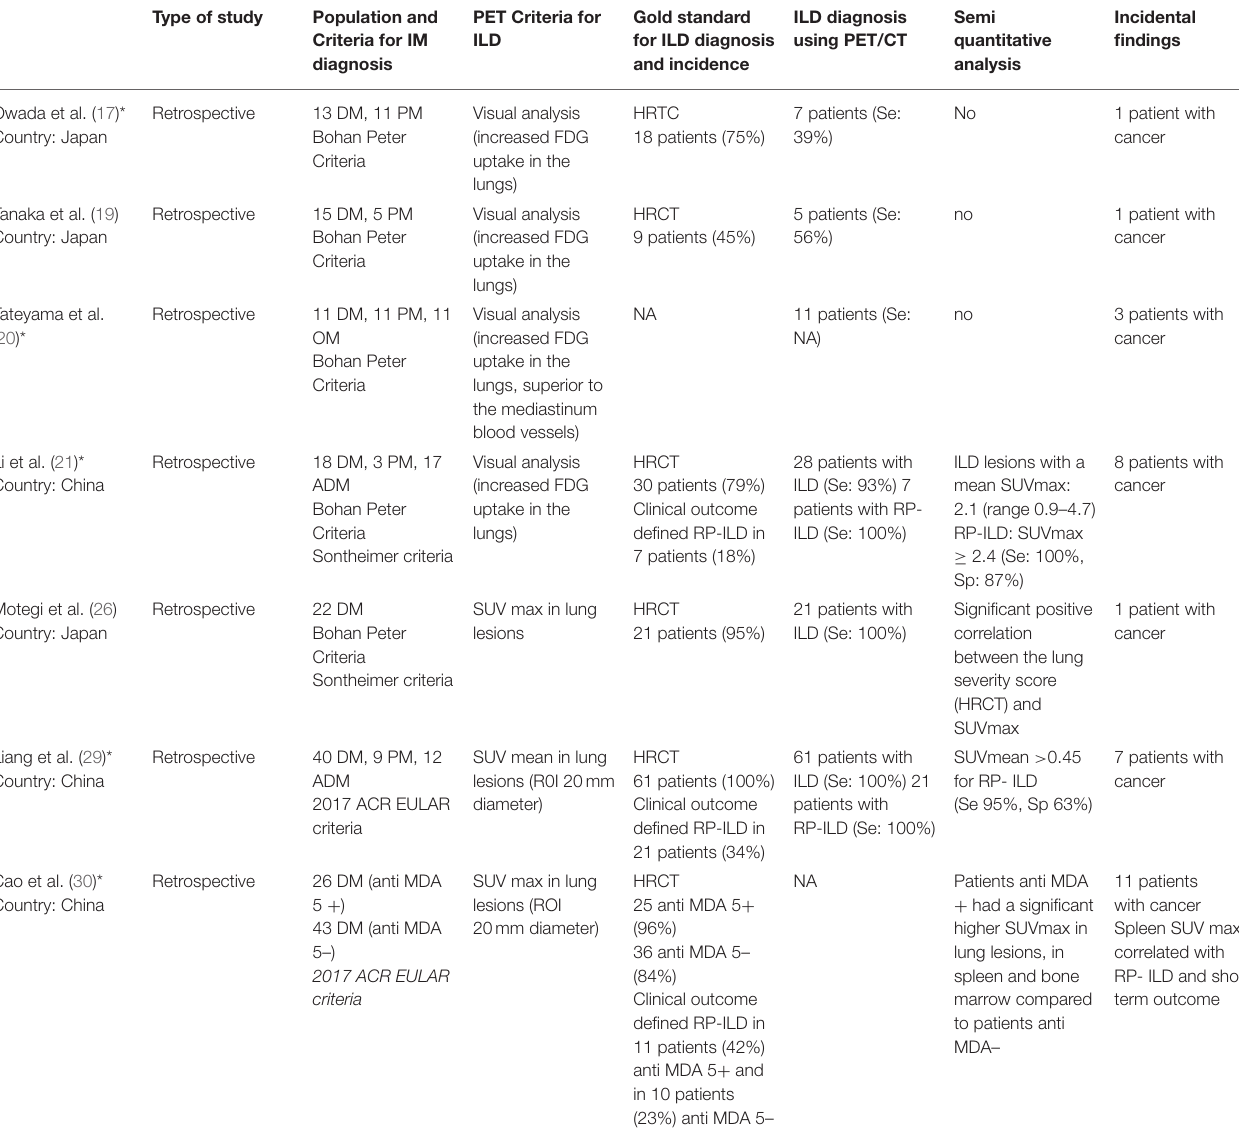
TABLE 3 | Studies evaluating the performance of [ 18 F]FDG-PET/CT for diagnosis of interstitial lung disease (ILD) associated to inflammatory